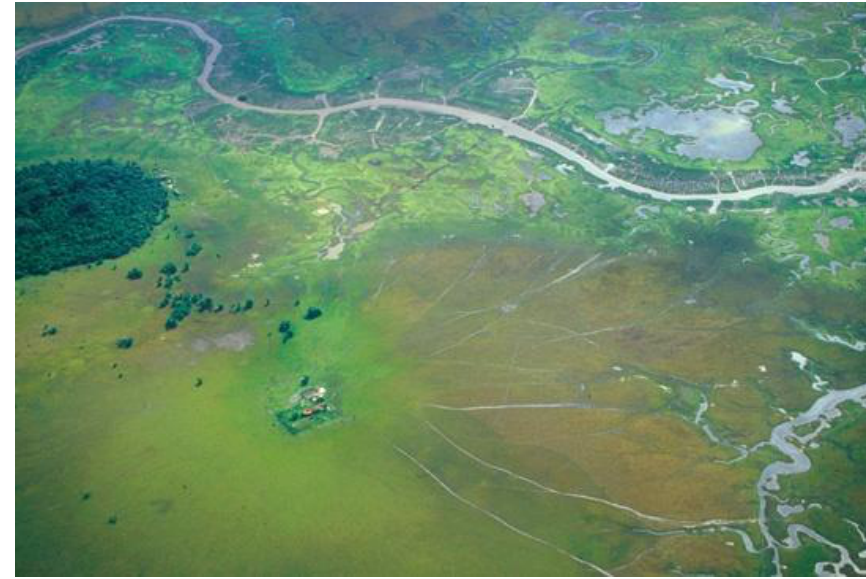
Figure 2. Aerial view of the savannas of southeastern Marajó Island. Photograph by Denise Schaan,